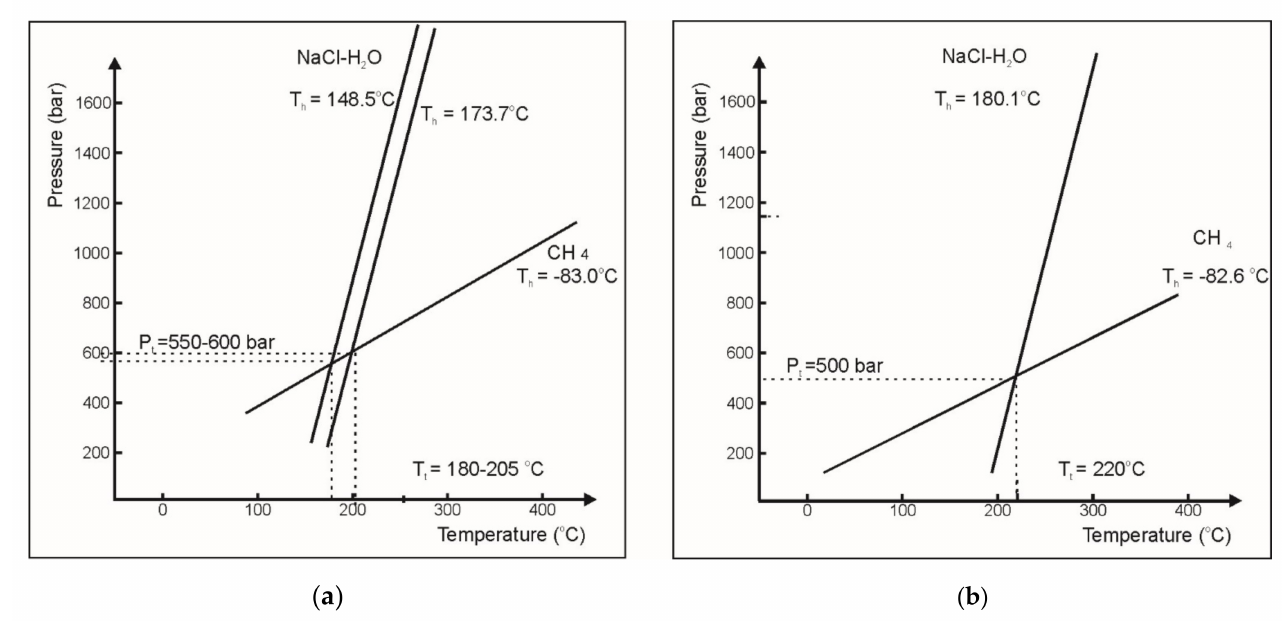
Figure 7. P-T trapping conditions for brine and methane in inclusions: ( a ) in carbonate (calcite) in MD, ( b ) in quartz in JRC. Isochores were calculated using FLINCOR program [30].